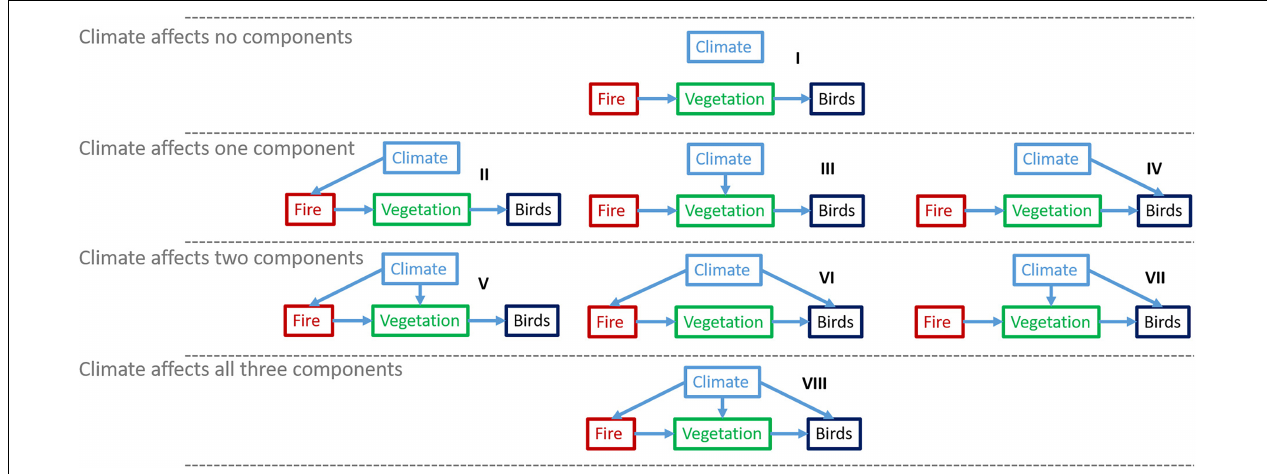
FIGURE 2 | Framework of the factorial experiment of vegetation (green), wildfire (red), and landbird (black) models. This factorial experiment covers the eight possible combinations of the two forms of the three models. The arrows represent the pathways via which climate might affect landbirds (“Birds”). Each graphical representation of the model combinations used can be matched with the model numbers (roman numbers) in Table 2